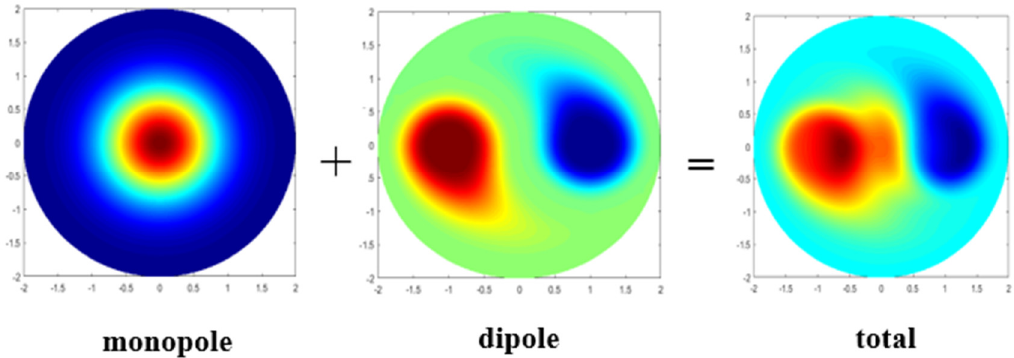
Figure 3. Composites of a CHL monopole and a CHL dipole.